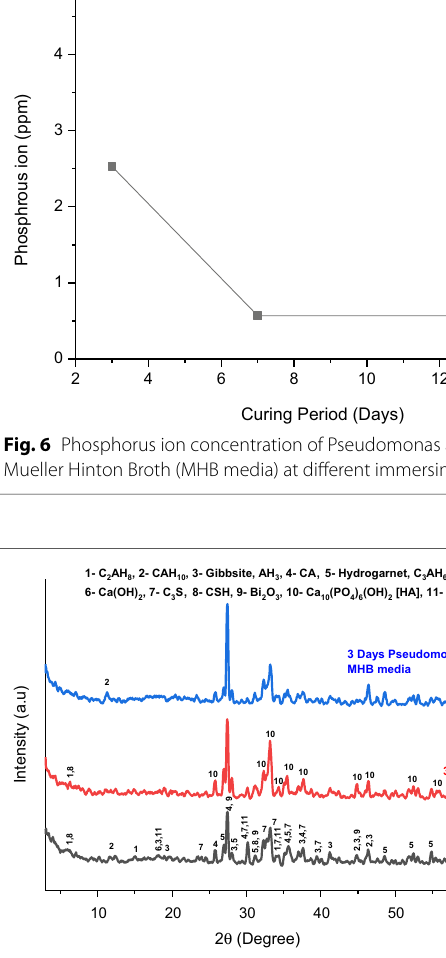
Fig. 7 X-ray diffraction patterns of 3-day sample cured in distilled water (DW) simulated body fluid (SBF) and Pseudomonas aeruginosa in Mueller Hinton Broth (MHB